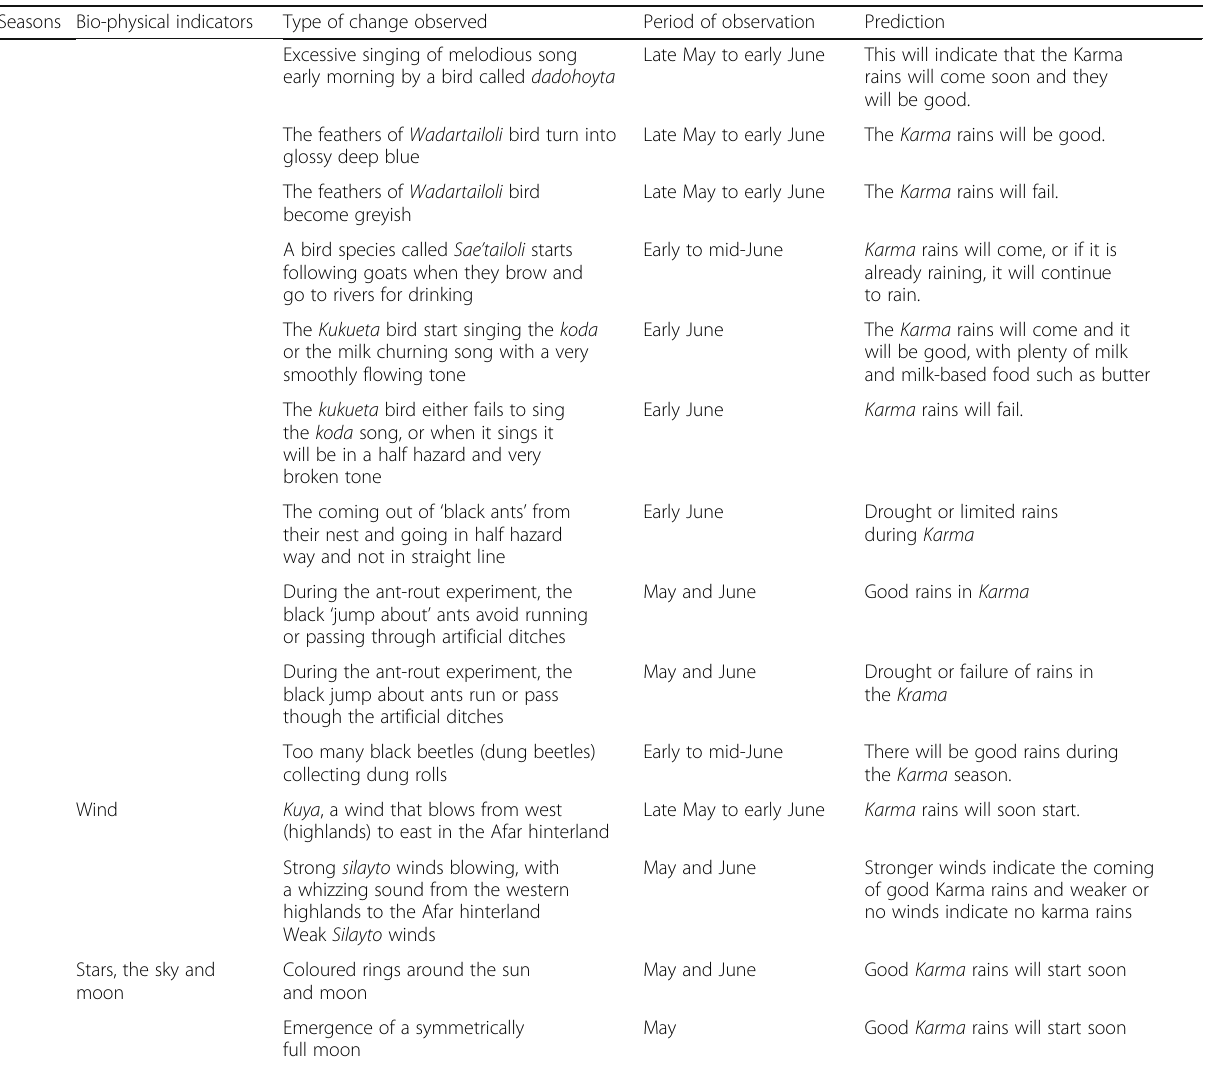
Table 3 Season-specific bio-physical indicators of indigenous weather prediction by Afar pastoralists (Continued) Seasons Bio-physical